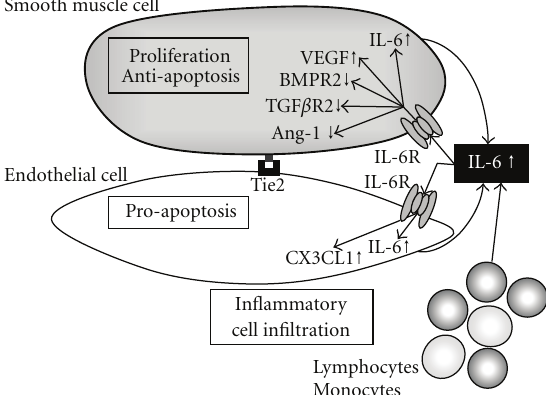
Figure 2: Hypothetical mechanism leading to pulmonary vascular remodeling via overexpression of IL-6. IL-6 induced proliferation and antiapoptosis in vascular smooth muscle cells through upregulation of VEGF, and downregulation of BMPR2 and TGF β R2. Upon IL-6 exposure, endothelial cells undergo apoptosis through repressed Tie2 signaling via downregulated Ang-1 expression in smooth muscle cells. Production of CX3CL1 results in recruitment of inflammatory cells, such as lymphocytes and monocytes, which produce enormous amount of IL-6, while vascular smooth muscle and endothelial cells also produce IL-6 upon stimulation with IL-6.